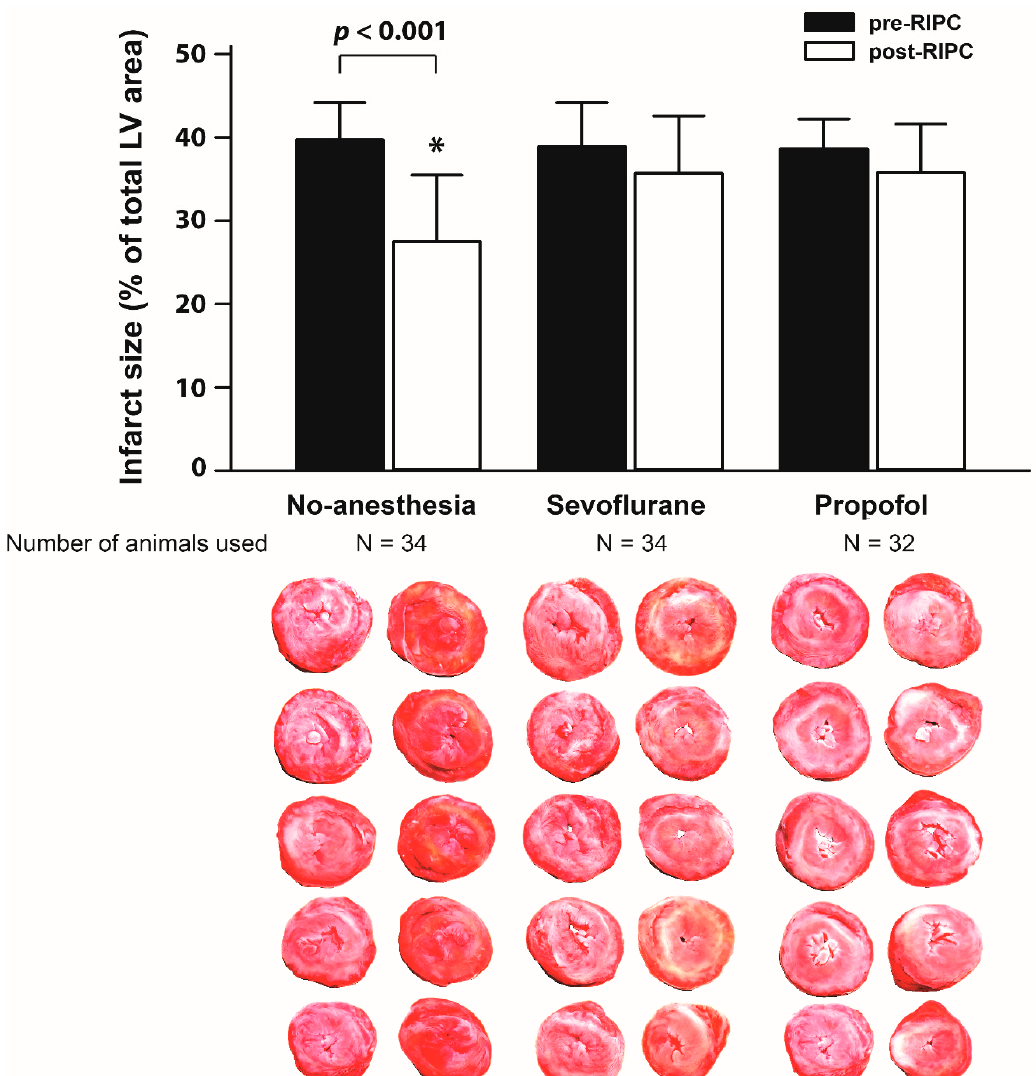
Figure 3. Comparison of pre- and post-RIPC infarct size of the Langendorff isolated rat heart model using dialysate from cardiac surgery patients under different anesthetic implication. Data are presented as mean ± SD. * p < 0.05 compared to the pre-RIPC infarct size within a group. LV, left ventricle; RIPC, remote ischemic preconditioning.